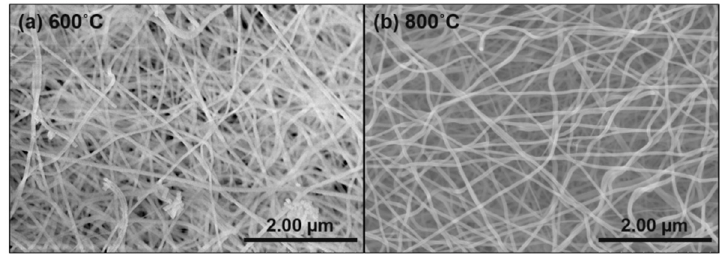
Figure 7. SEM images of electrospun Al 2 O 3 microfibers annealed for 2 h at ( a ) 600 °C and ( b ) 800 °C.